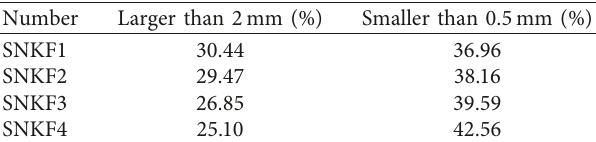
Table 3: Water content test results.